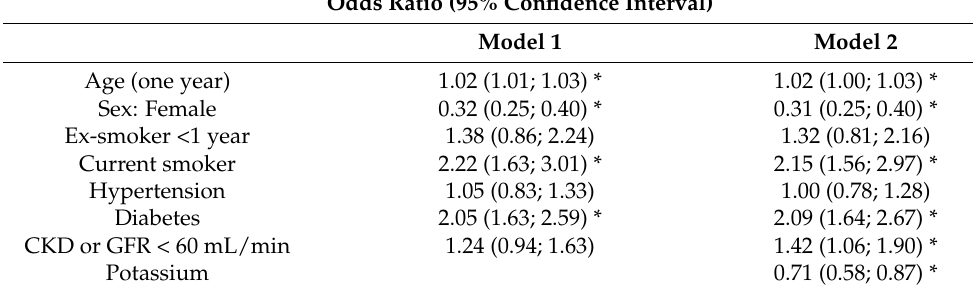
Table 3. The odds ratio of coronary lesions with ≥ 30% stenosis for classical cardiovascular risk factors. The effect is mutually adjusted and adjusted for age and sex in Model 1 and further adjusted for serum potassium in Model